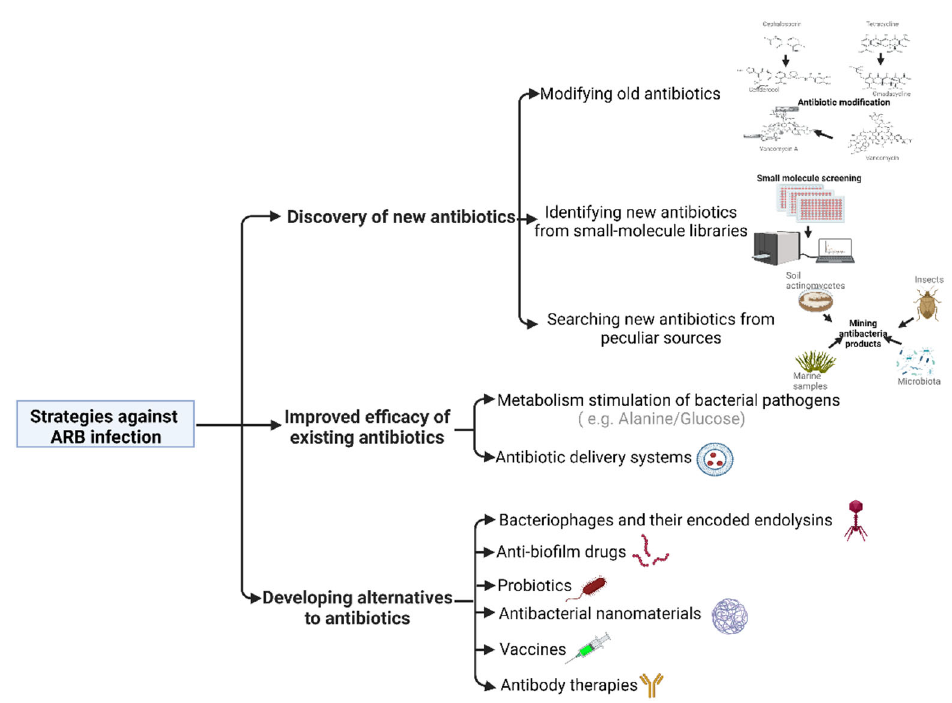
Figure 1. Strategies against antibiotic ‐ resistant bacterial infection.